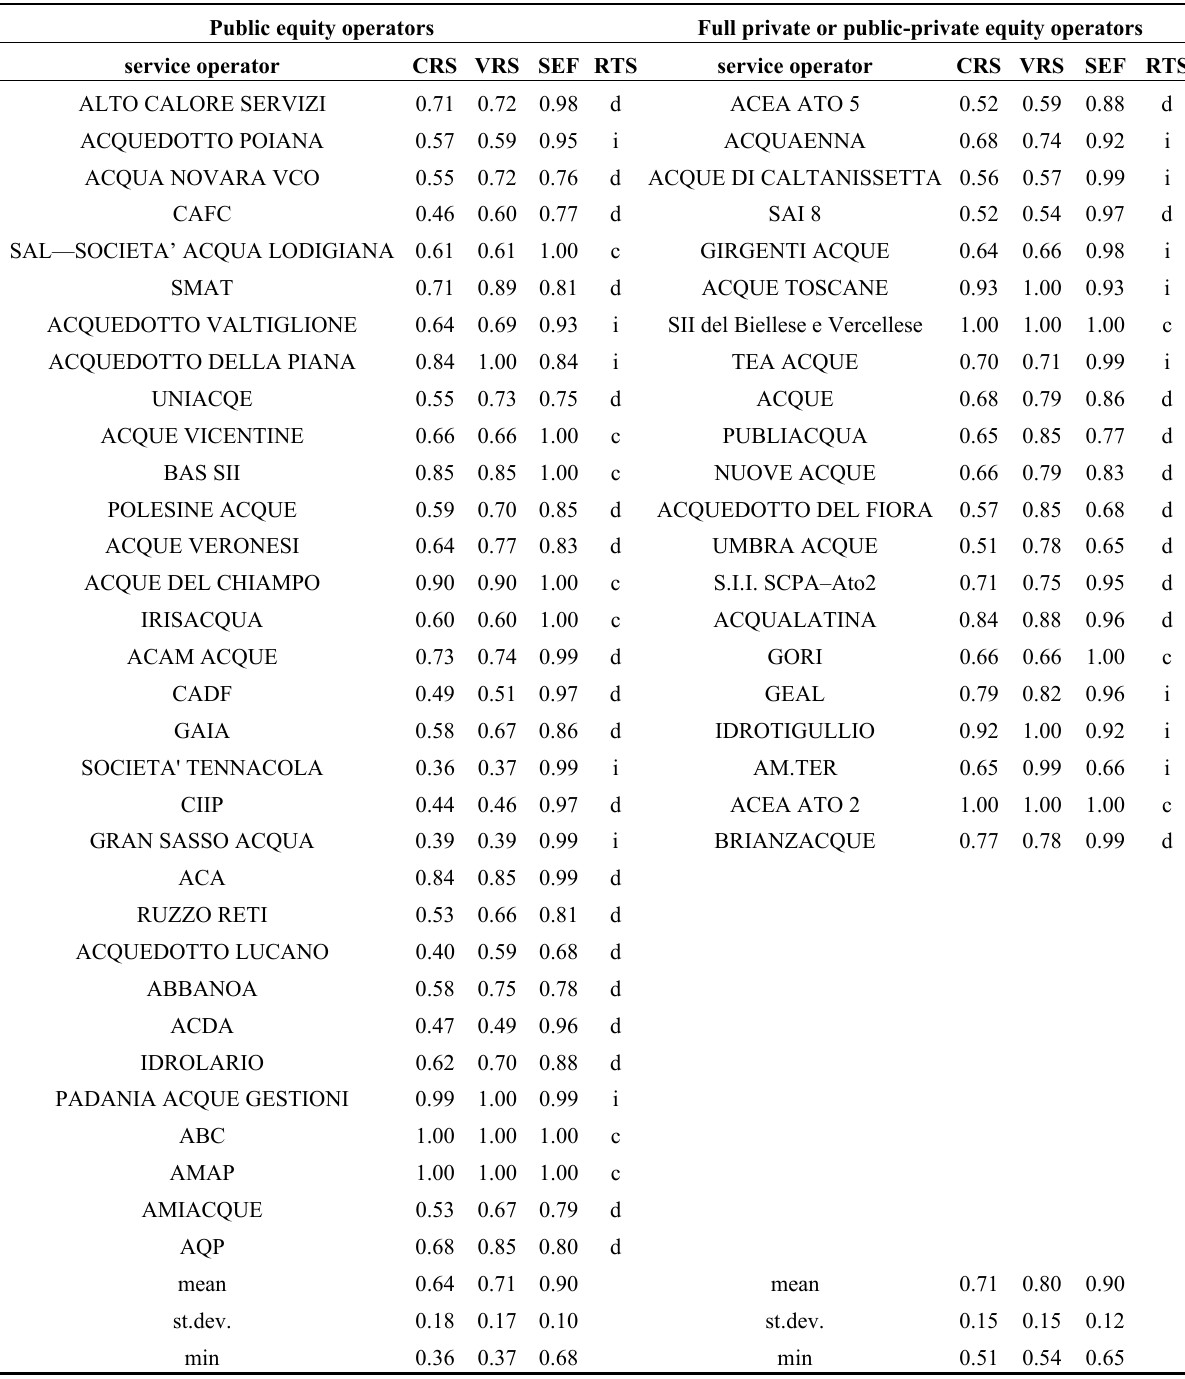
Table 6. Efficiency